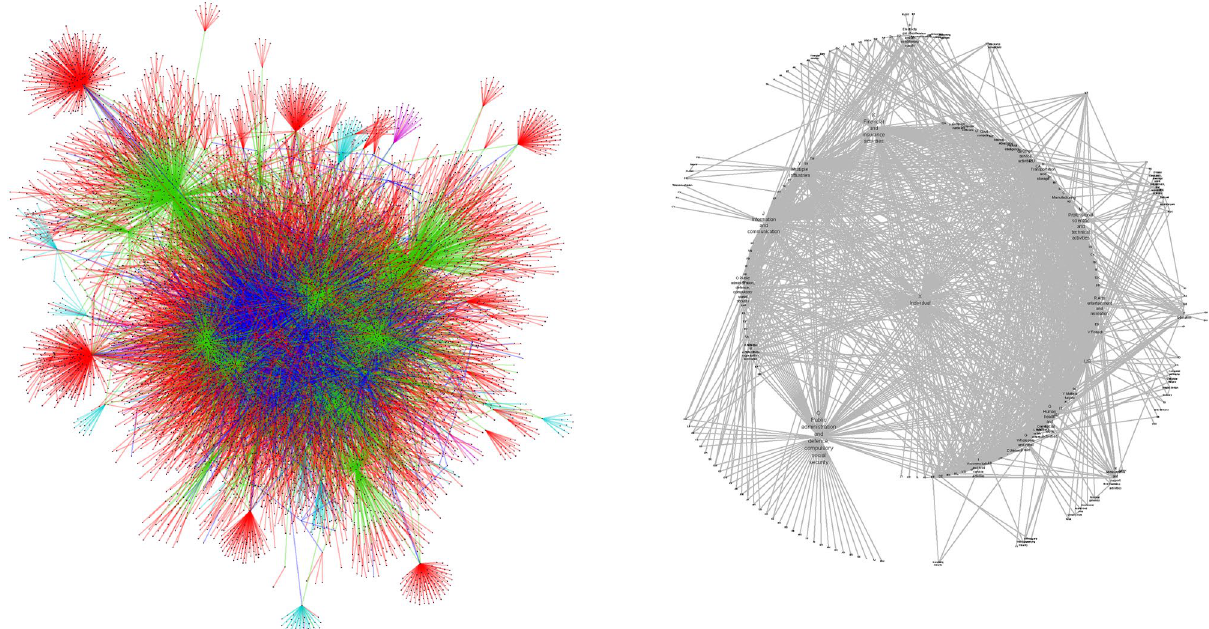
Figure 6. (Left) The resulting knowledge graph from the Hackmageddon dataset. The edges are coloured according to the interaction in the related triples such that red edges represent the attack triples (attackedBy), blue edges represent hasCountry, green edges represent hasIndustry, purple edges represent hasProduct triples, and turquoise edges represent hasParent triples. (Right) The projection of the central nodes used in